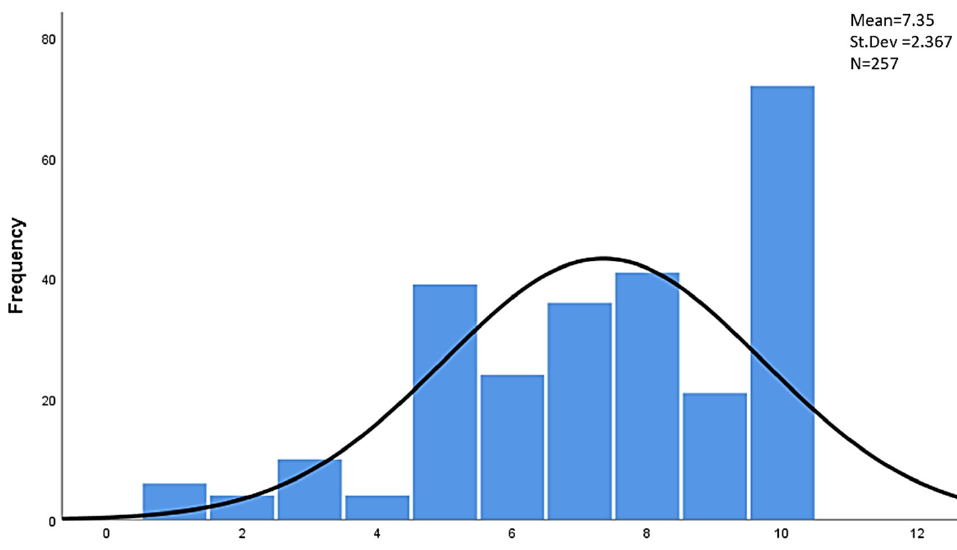
Figure 2. Scale of readiness to start working on change in the way pharmacists function.